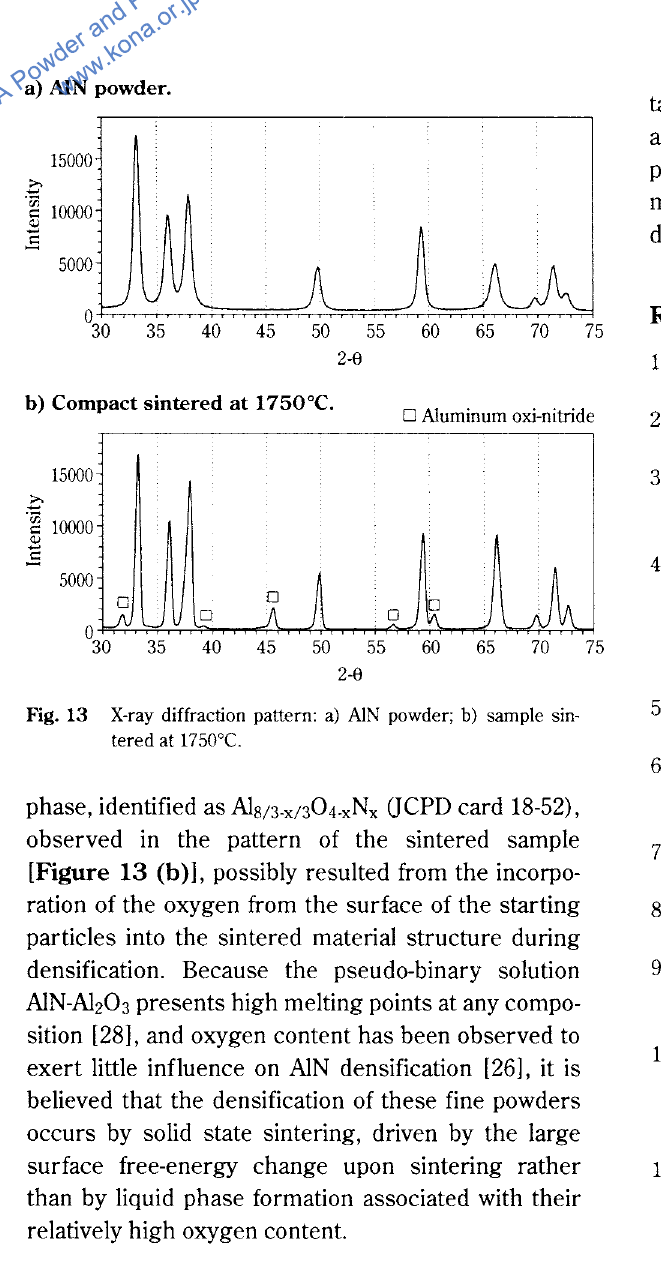
Fig. 13 X-ray diffraction pattern: a) AIN powder; b) sample sin tered at